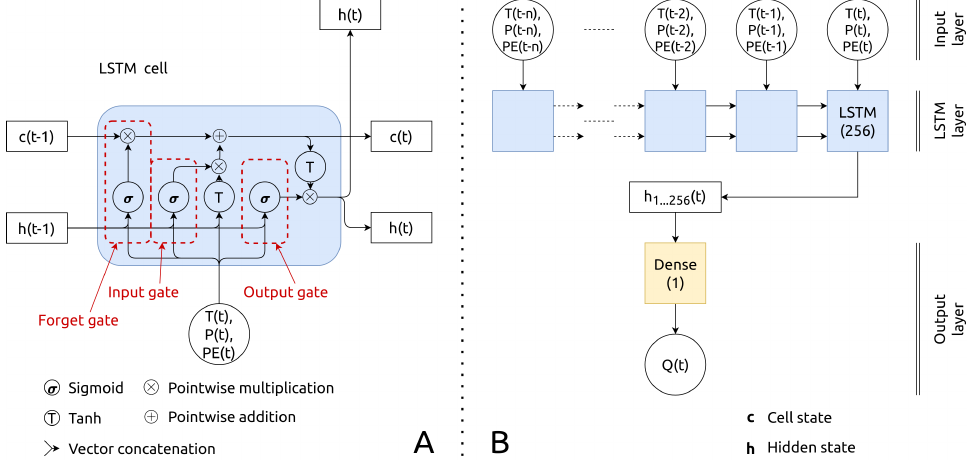
Figure 3. ( A ) The internal operations and activation functions of a Long Short-Term Memory (LSTM) cell, ( B ) a general representation of the LSTM